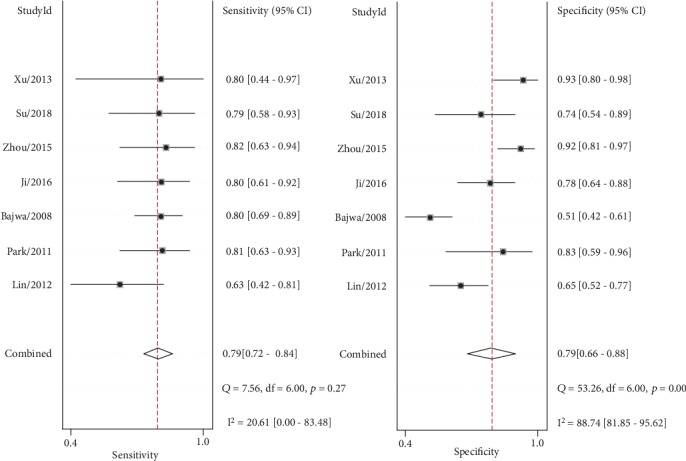
Summary sensitivity and specificity plotted on forest graphs for NT-proBNP in predicting the mortality of patients with ARDS.